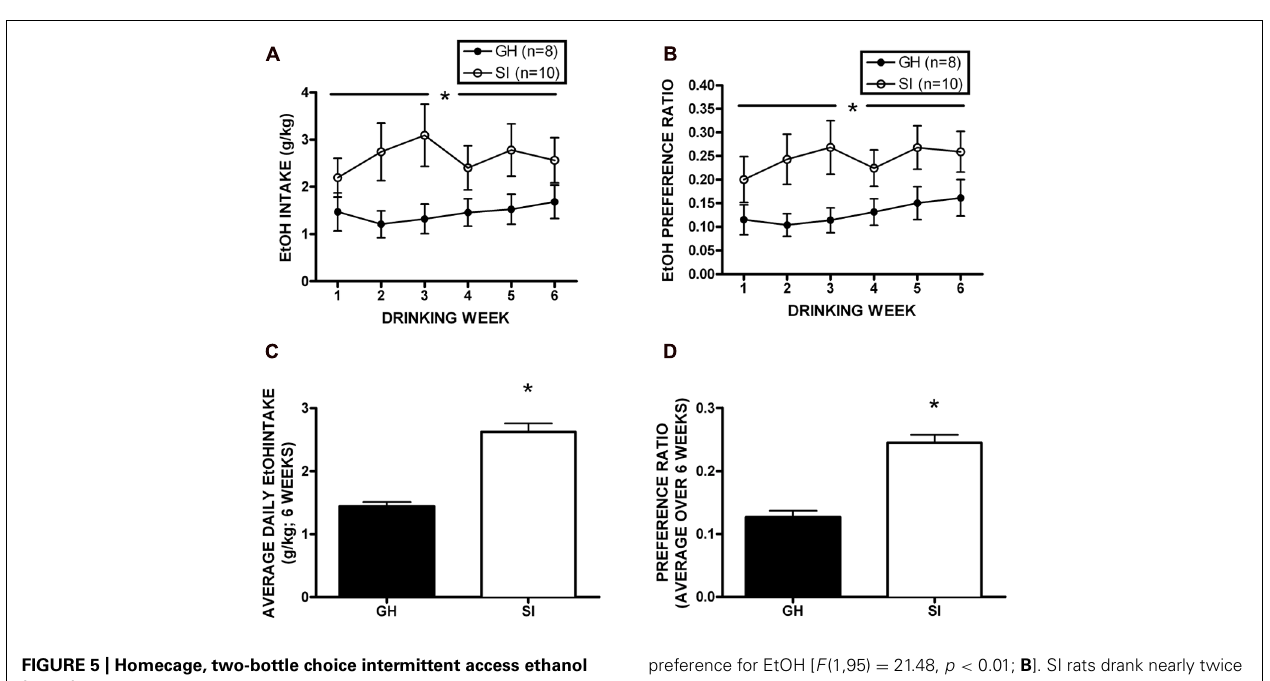
FIGURE 5 | Homecage, two-bottle choice intermittent access ethanol (EtOH) self-administration. Socially isolated (SI) rats drank significantly more EtOH than group housed (GH) rats over the 6 week period [ F (1,96) = 18.73, p < 0.01; A ], and SI rats showed significantly greater